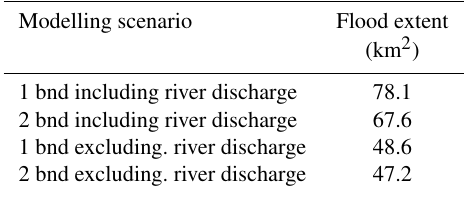
Table 1. Flood extents resulting from different modelling